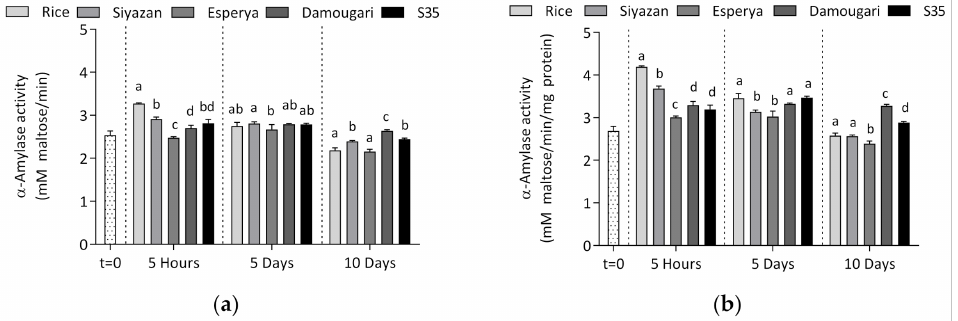
Figure 3. Evolution of ( a ) α -amylase activities and ( b ) specific α -amylase activities of larval extracts as a function of intake type and feeding duration. Different letters indicate statistically significant differences at p = 0.05 (Tukey